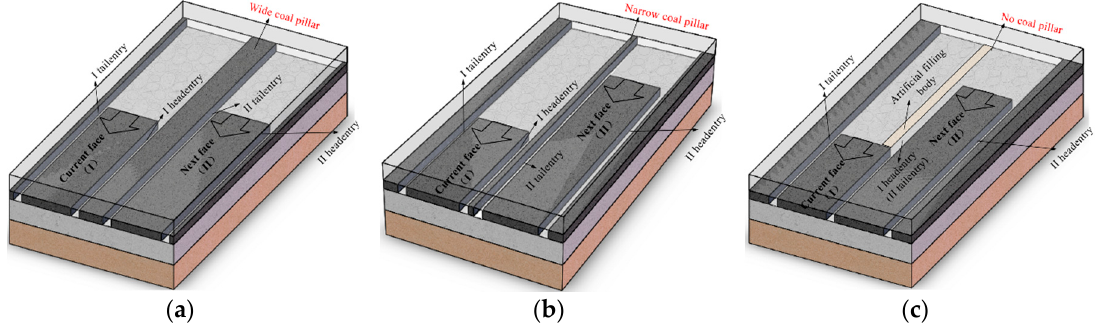
Figure 1. Three typical longwall mining schemes. ( a ) Large-pillar mining; ( b ) Small-pillar mining; ( c ) Zero-pillar mining.